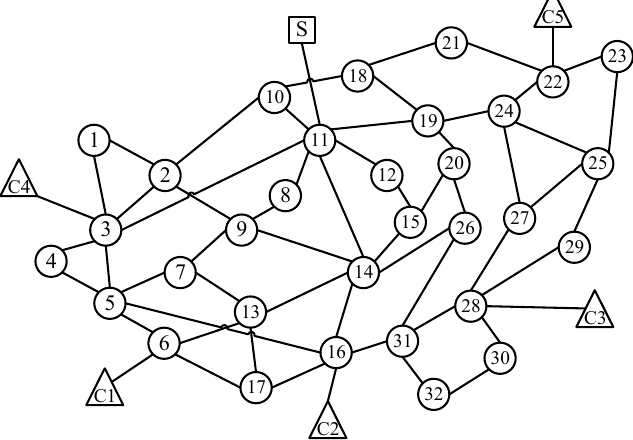
Figure 3. Simulation topology (GEANT2).